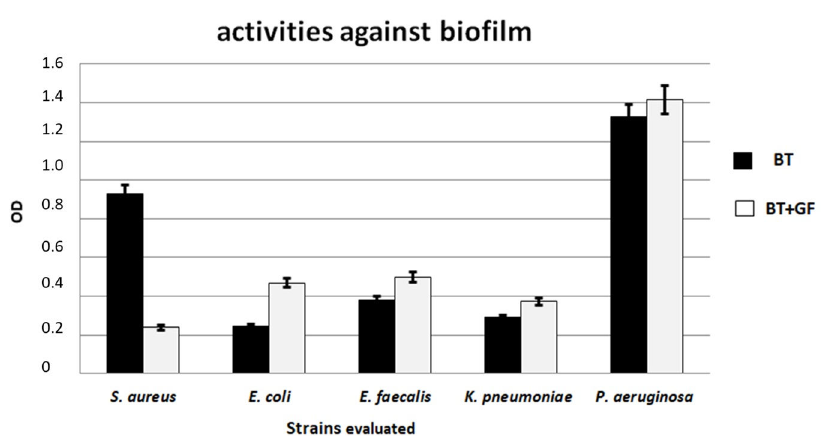
Figure 4. E ff ect of the cold water extract from the albino Grifola frondosa basidioma on biofilm production (expressed as optical density, OD) by five bacterial species. BT: biofilm produced in the absence of the fungal extract; BT + GF: biofilm produced in the presence of the fungal extract. The experiment was conducted in